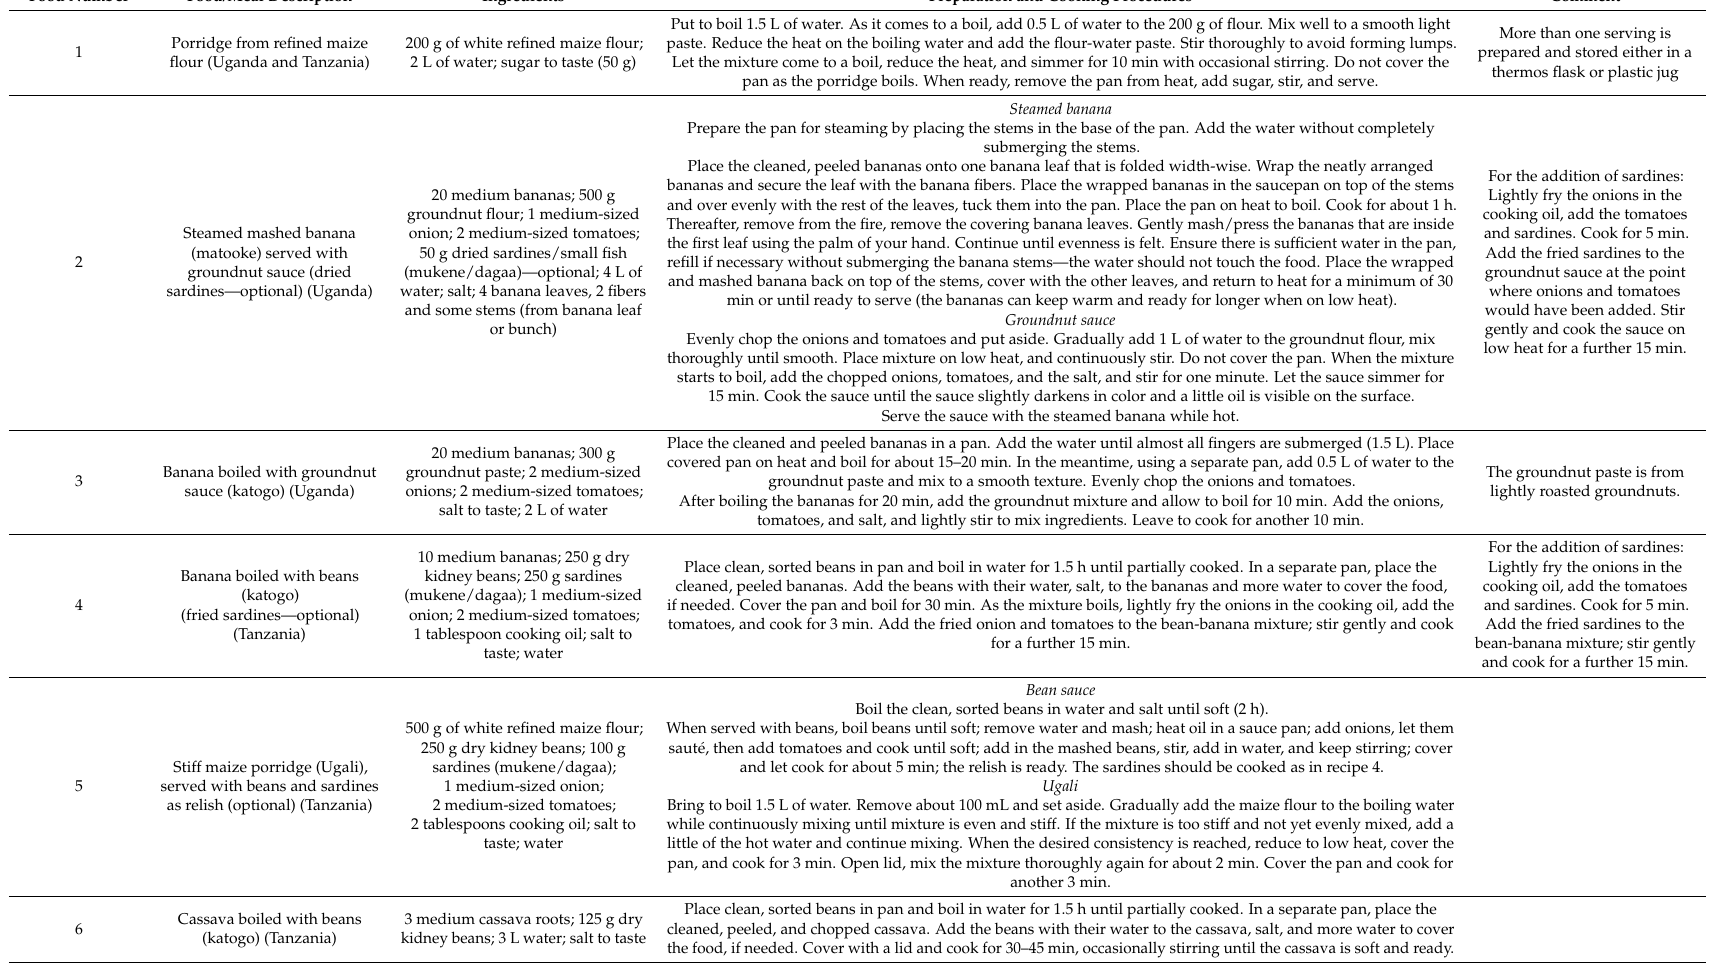
Table 1. Description of the recipes of the six most popular foods given to children aged 12–59 months in North Western Tanzania and Central Uganda. Food